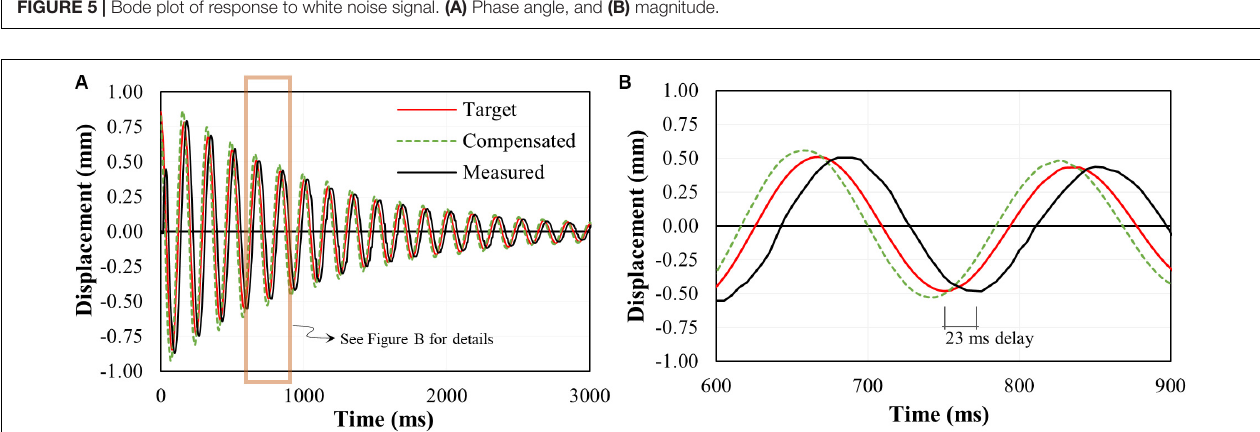
FIGURE 5 | Bode plot of response to white noise signal. (A) Phase angle, and (B) magnitude.